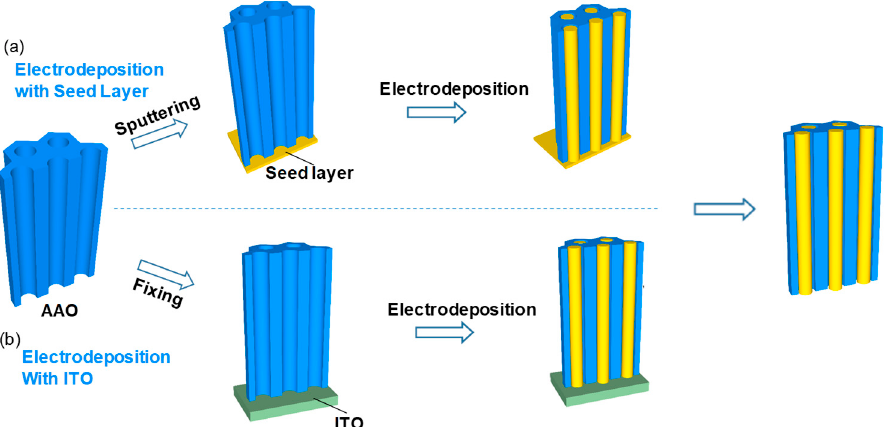
Figure 1. The schematic diagram of electrodeposition ( a ) with seed layer and ( b ) with indium tin oxide (ITO) glass.